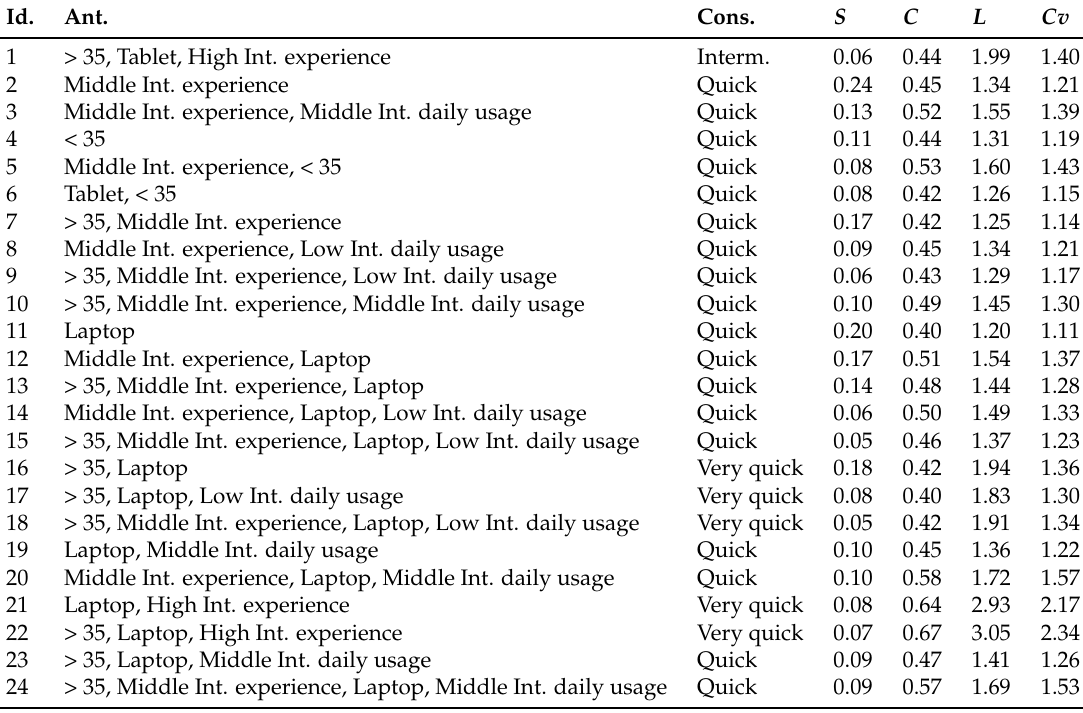
Table 1. The set of the extracted association rules for Dice 1 CAPTCHA. The number of attempts in the consequent is 1 for all ARs (consequently, it is